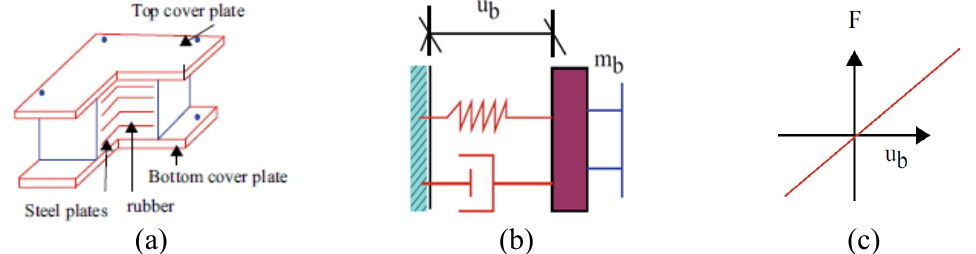
Fig. 3. (a) Laminated rubber bearing (b) Idealization of LRB model (c) Force deformation behaviour of LRB [2]